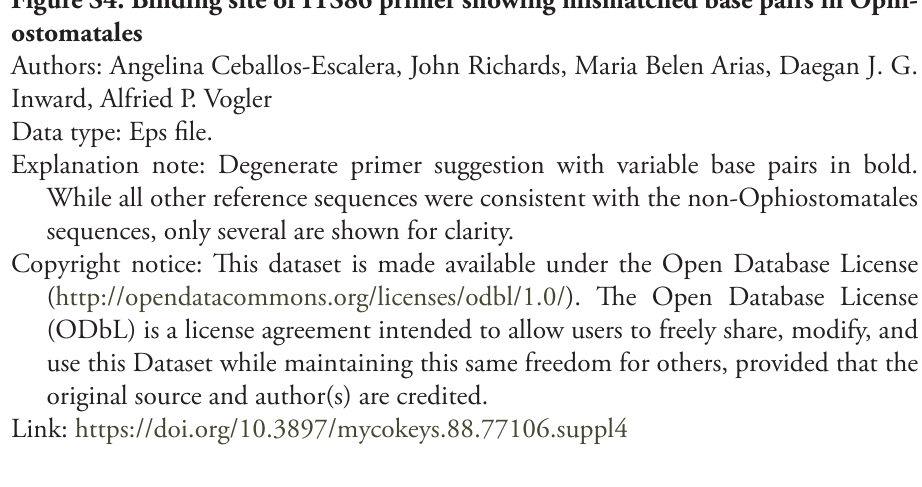
Figure S4. Binding site of ITS86 primer showing mismatched base pairs in Ophi-